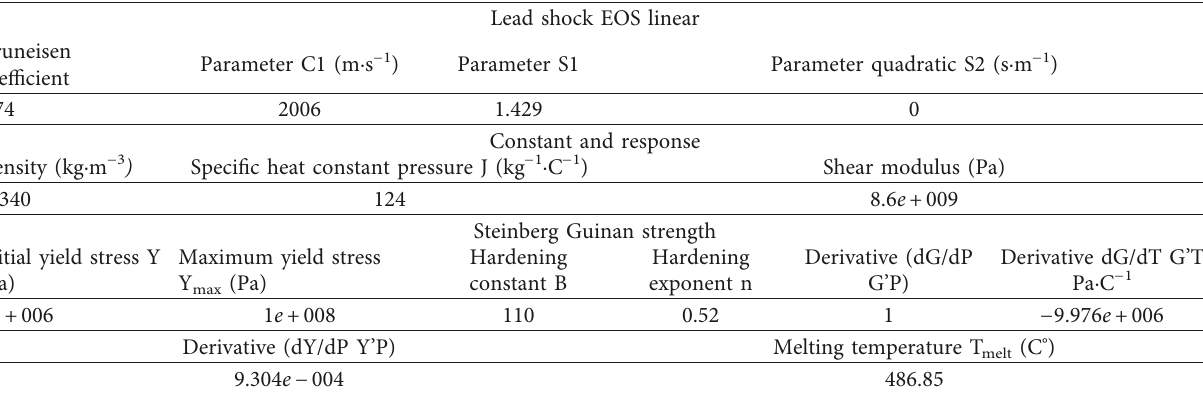
Table 3: Material modeling of bullet core lead